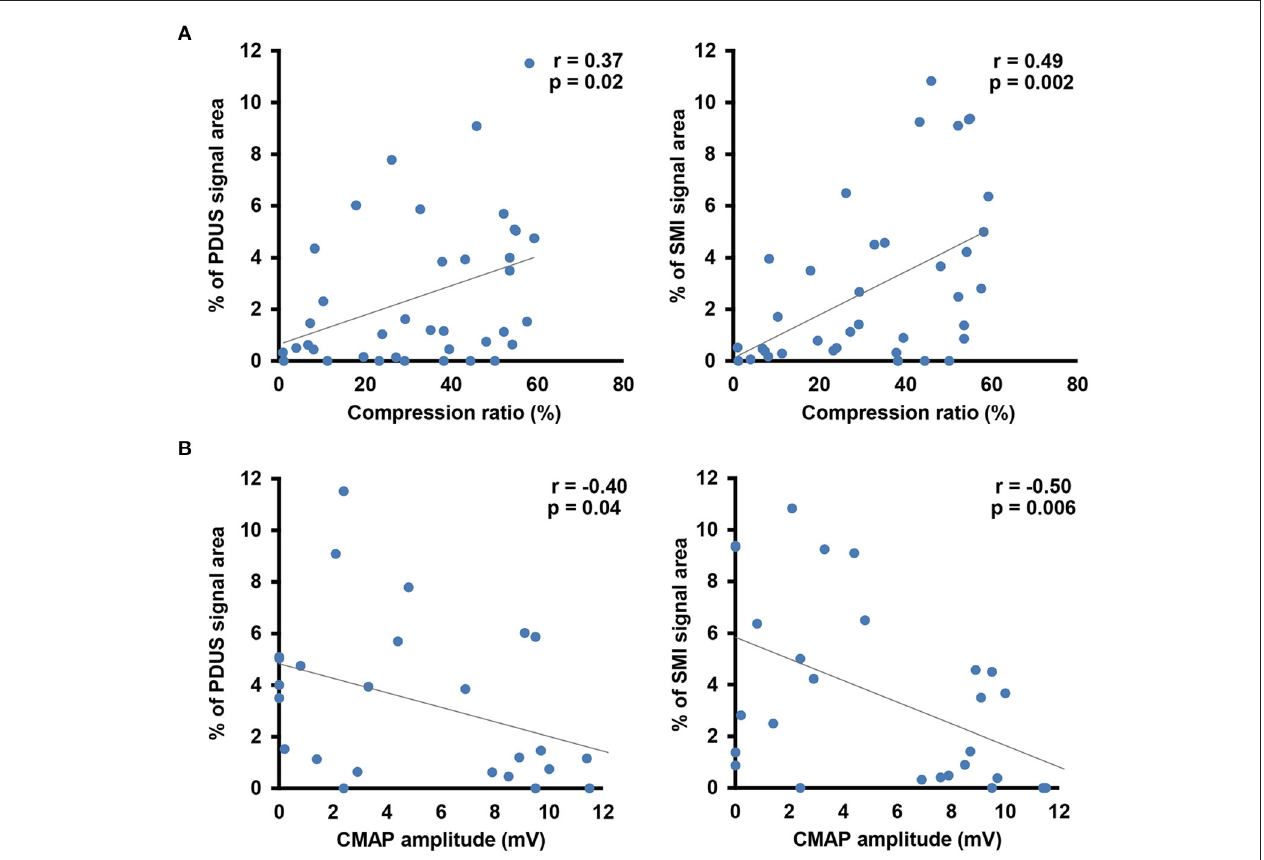
FIGURE 4 | Correlation analysis between the blood flow signal and morphological changes in the median nerve (A) or the electrophysiological severity of median nerve neuropathy (B) . Gray line indicates the regression